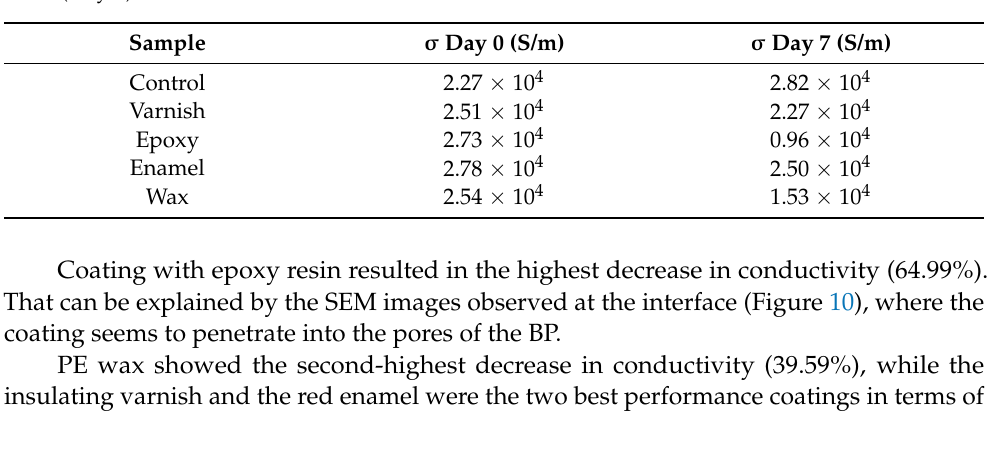
Table 6. Average conductivity change ( ∆σ ) of each set of 3 samples from their first day of measure- ment (Day 0).